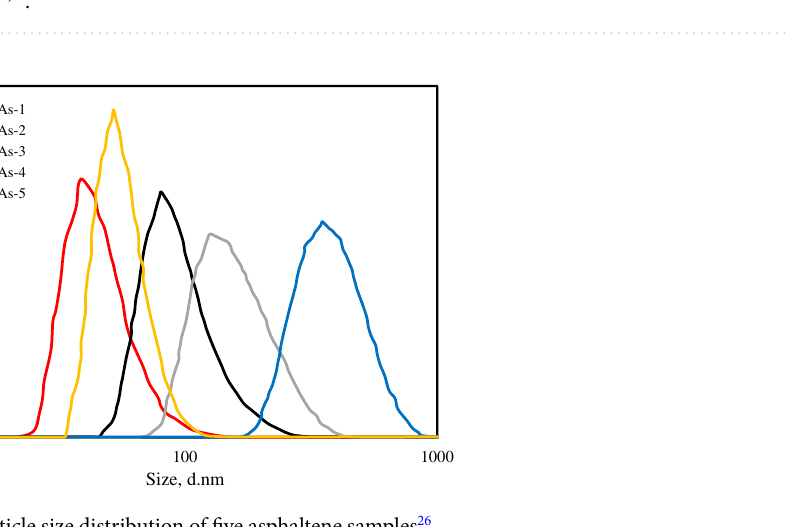
Figure 4. Particle size distribution of five asphaltene samples 26